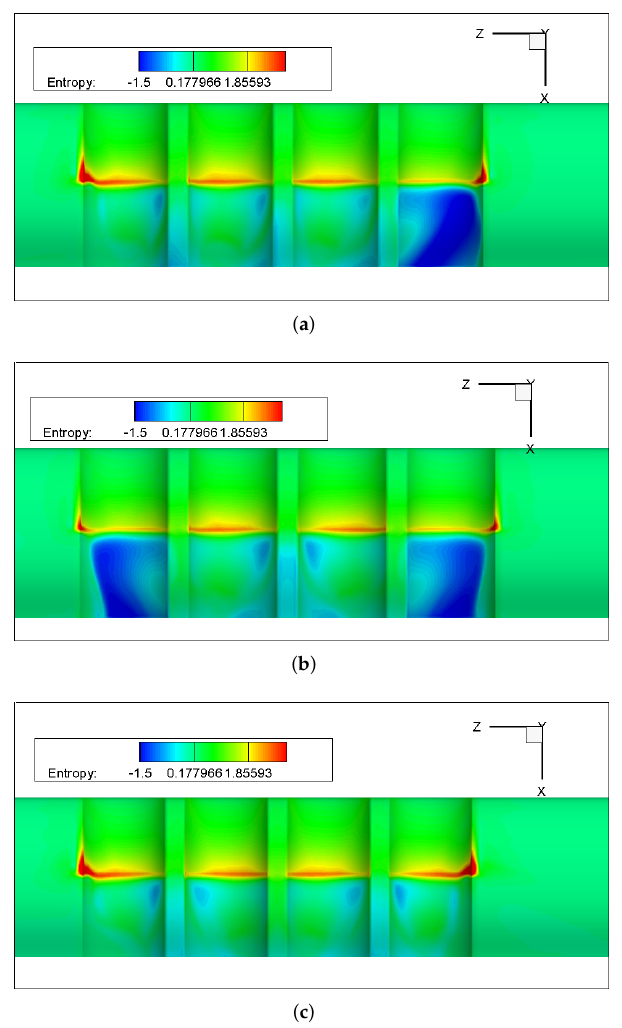
Figure 17. Entropy contour of different configuration. ( a ) Multi-propeller CW (NNNN); ( b ) Multi- propeller CW (NPNP); ( c ) Multi-propeller CW